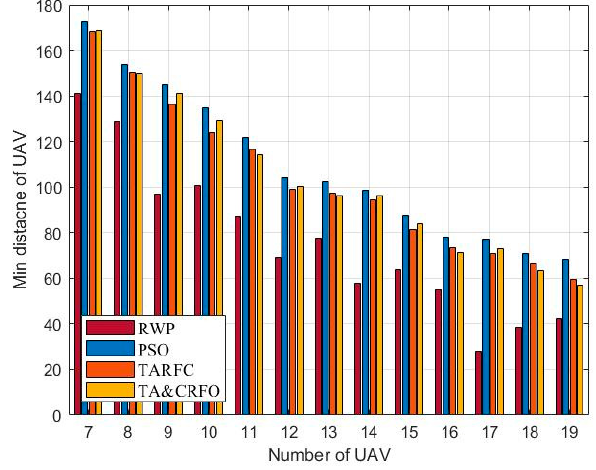
Figure 13. The shortest UAV distance of FANET constructed by different algorithms.